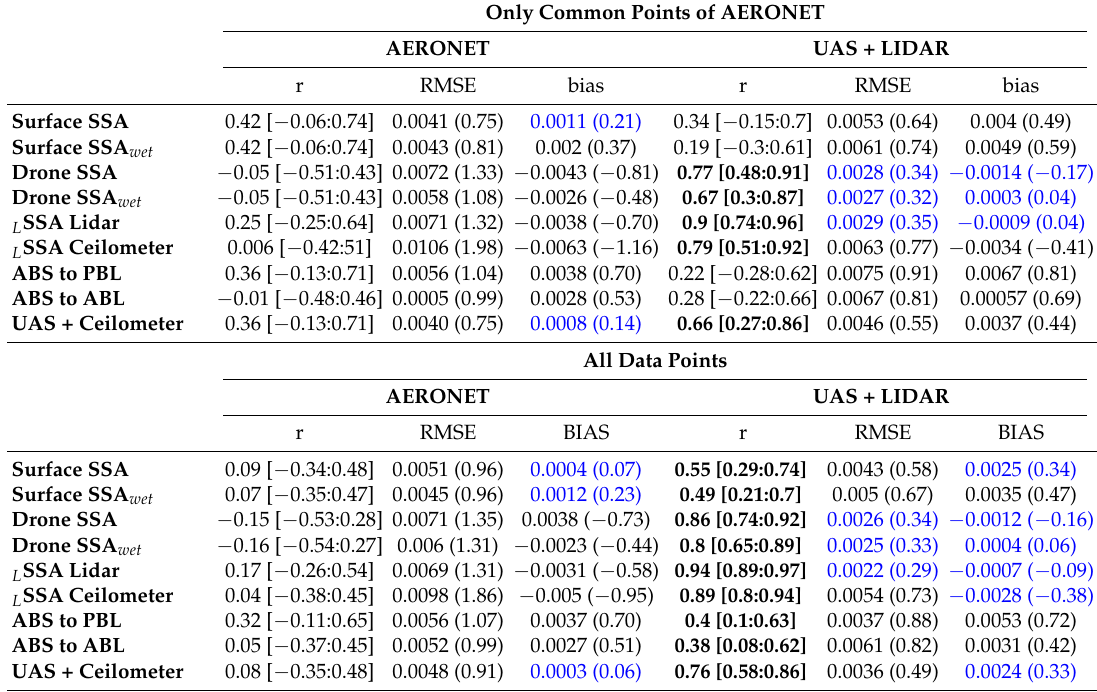
Table 4. Correlation coefficient between AERONET AAOD or AAOD approximated from UAS + lidar measurements and different AAOD approximation methods. 95% confidence intervals for correlation are presented in square brackets. Significant Pearson correlation coefficients are presented in bold. Root mean squared error (RMSE) and bias for linear fit with relation to the mean value shown in brackets (in blue when values are below 40% of the mean